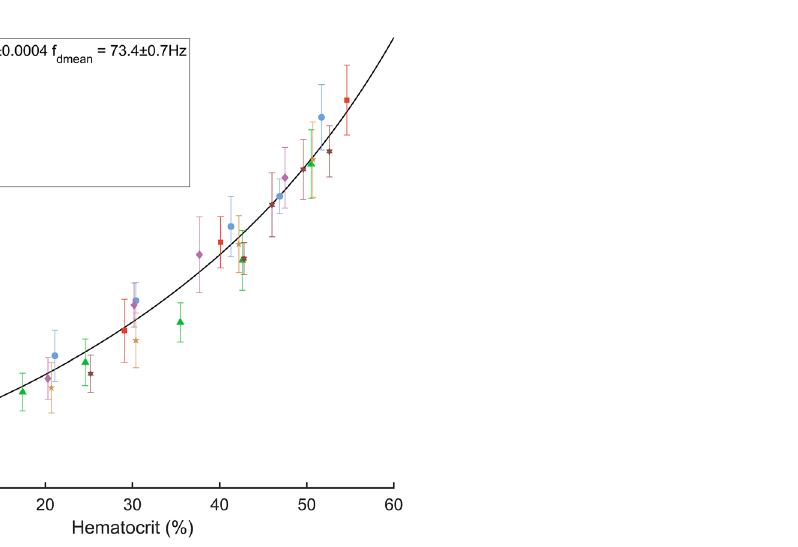
Figure 6. Measured τ parameters with a fit of Eq.